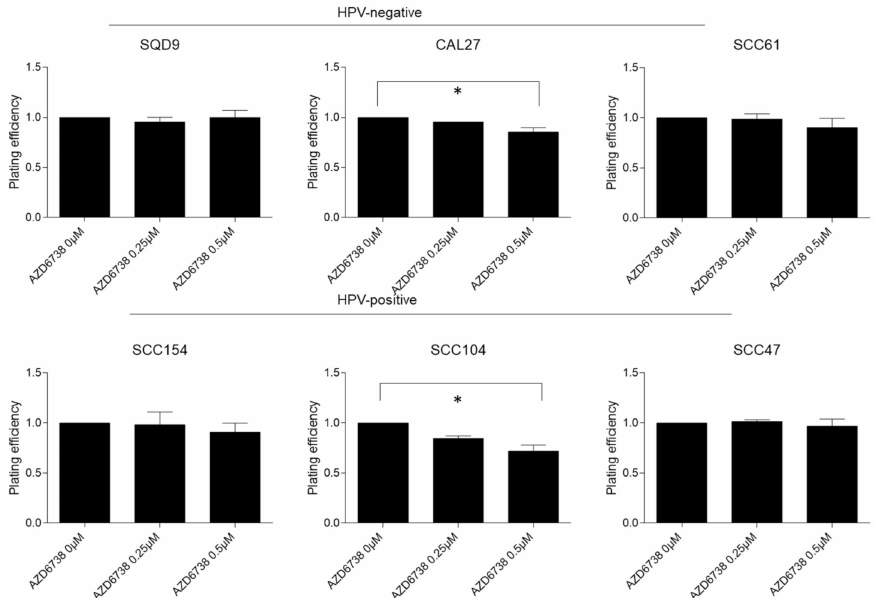
Figure 1. Effect of ATR inhibition on clonogenic survival in HPV-negative and HPV-positive HNSCC cells. HPV-negative (SQD9, CAL27, and SCC61) and HPV-positive (SCC154, SCC104, and SCC47) cells were treated for 24 h with DMSO or AZD6738 at indicated doses. Plating efficiency was determined by the means of clonogenic survival and is shown as the mean clonogenic survival fraction ± s.e.m. relative to vehicle treated control cells, n = 3. * p -values were calculated with one-way ANOVA with Bonferroni correction for multiple